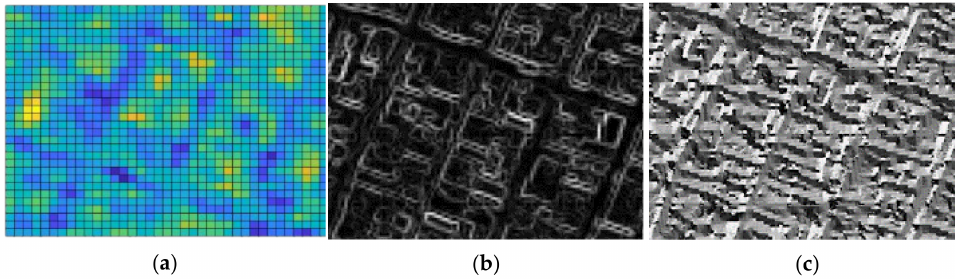
Figure 4. Area classification using environmental information ( a ) Noise and pattern, ( b ) gradient image, ( c ) Data Matching.